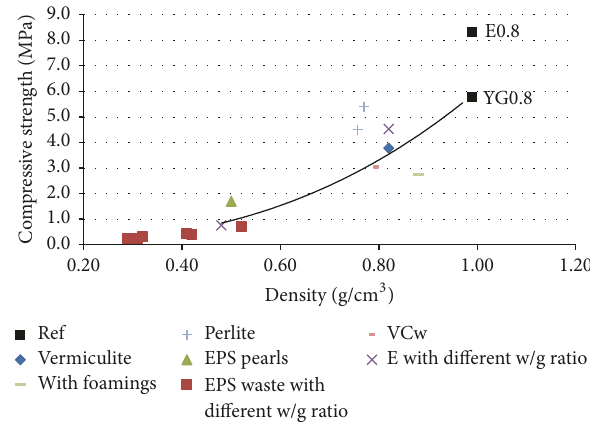
Figure 3: Comparison of proposed model with the results obtained by other authors. Compressive strength.